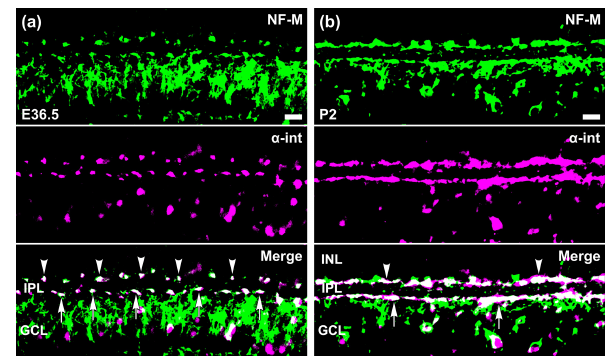
Figure 6. Development of starburst amacrine cells in the retina of Tupaia belangeri . Double-immunofluorescence with antibod- ies against medium-molecular-weight neurofilament (NF-M, green) and α -internexin ( α -int, magenta). (a) Embryonic day 36.5: coex- pression of NF-M and α -int in the supranuclear cytoplasm of or- thotopic (arrowheads) and displaced starburst amacrines (arrows). (b) Postnatal day 2: coexpression of NF-M and α -int in the de- veloping dendritic strata of orthotopic (arrowheads) and displaced starburst amacrines (arrows). GCL, ganglion cell layer; INL, inner nuclear layer; IPL, inner plexiform layer. Scale bars = 10µm. Re- produced from Knabe et al. (2007, Fig. 6a, b). © 2007 Wiley-Liss, Inc., by permission of John Wiley & Sons, Inc.